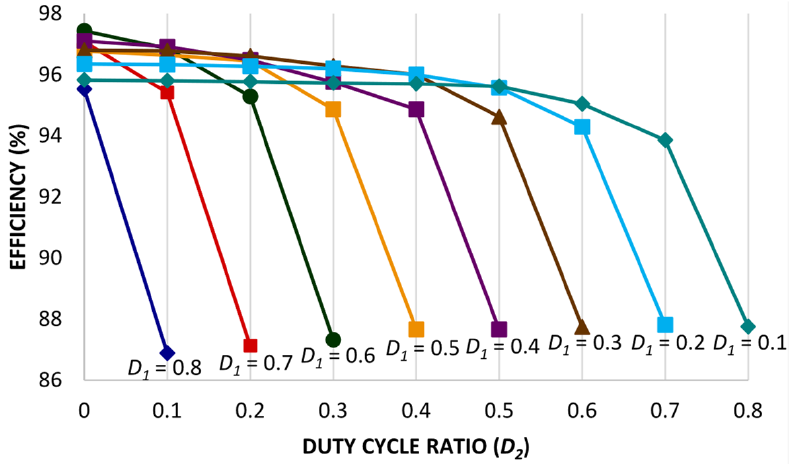
Figure 7. Proposed converter’s theoretical efficiency under varying duty cycle ratios D 1 and D 2 .